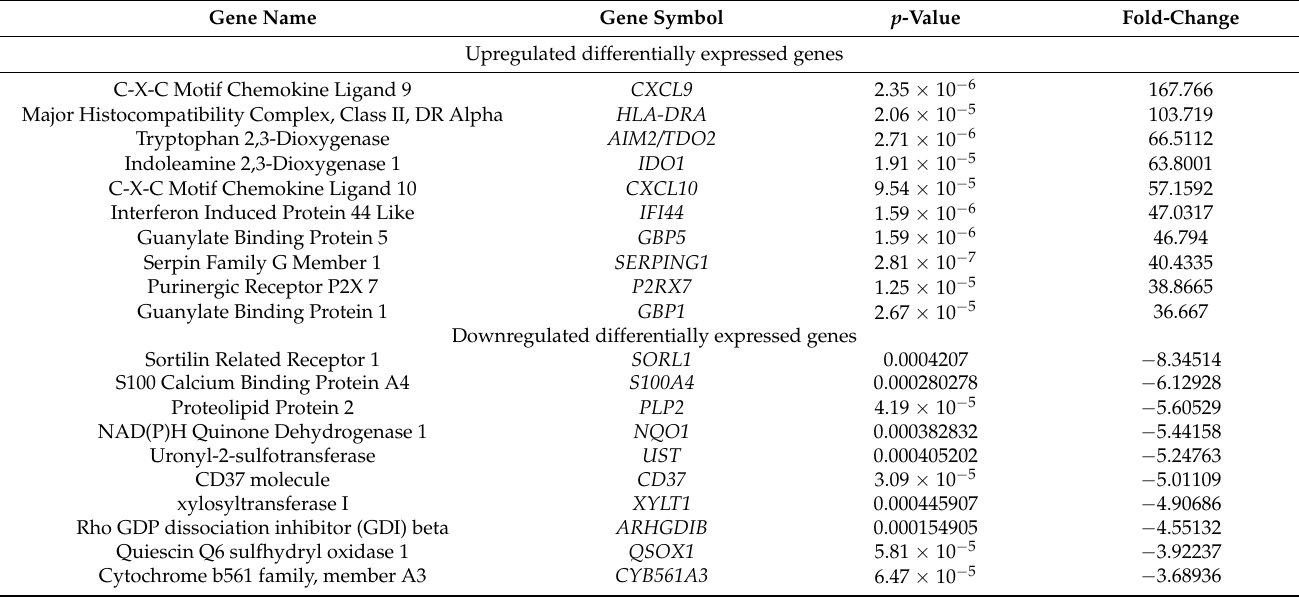
Table 2. Genes most significantly differentially up- and downregulated by IFN- γ + kaempferol treatment vs.